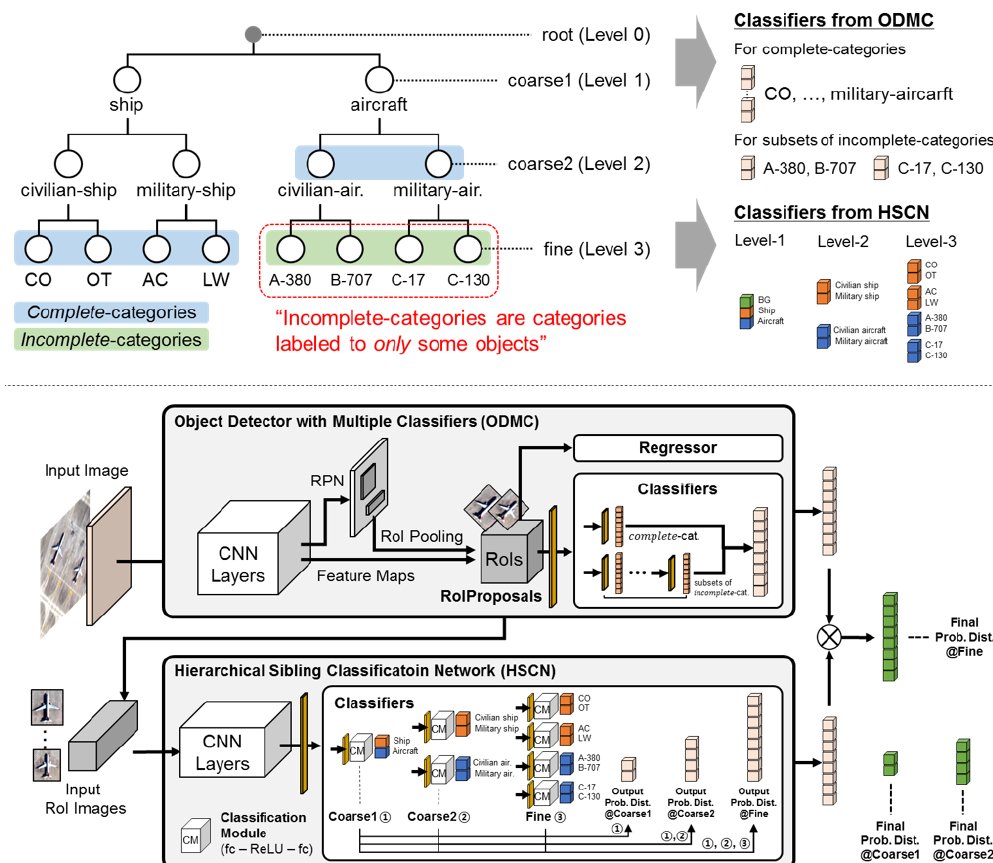
Figure 6. Top : A simplified example of hierarchically partial-annotated objects with their hierarchical labels. Two types of category sets. We define two kinds of category sets called complete -categories and incomplete -categories. The complete -categories represent the set of end-labeled classes that have any ancestor which is not an end-labeled class, while the incomplete -categories denote all the descendants of complete -categories. The short names for the categories are defined as: CO=COntainer, OT=Oil Tanker, AC=Aircraft Carrier, and LW=Large Warship. Bottom : Pipeline of decoupled hierarchical classification refinement. We build this pipeline through combining two networks in a sequential manner: 1) an Object Detection network with Multiple Classifiers (ODMC); 2) a Hierarchical Sibling Classification Network (HSCN) for supporting hierarchical multi-label classification. In HSCN, we place classification modules on each sibling classifier, where a classification module is composed of fully connected (fc)-ReLU [38]-fc